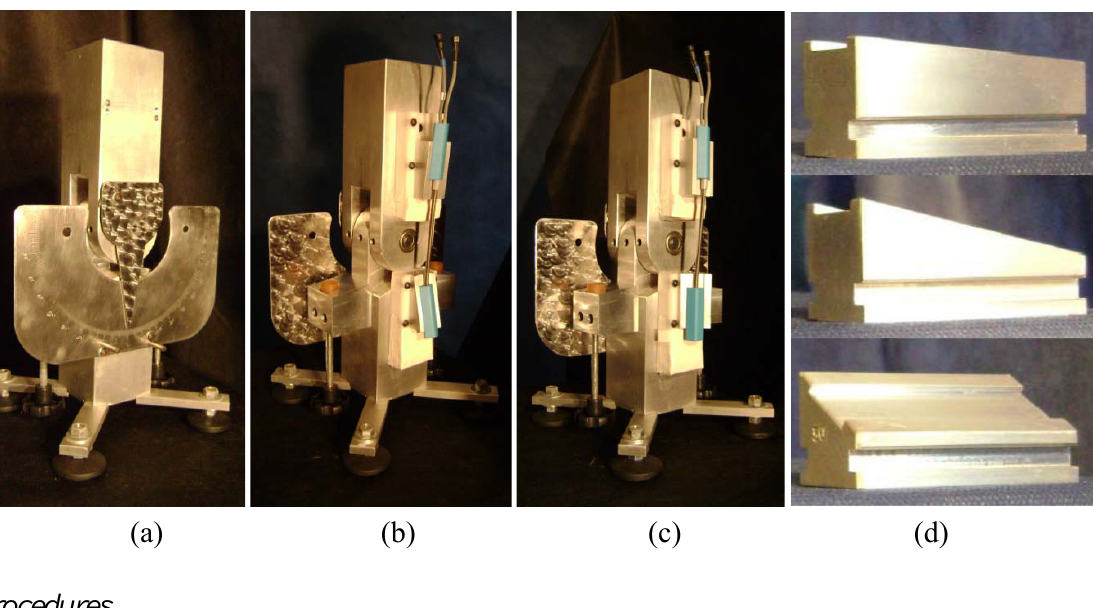
Figure 4. Jig, wedges and electrogoniometer used in the tests. (a) The graded angular scale is seen at the back of the jig; (b) 20° valgus misalignment wedges (in bright color) applied to the goniometer endblocks mounted in the jig: upper wedge 6° and lower wedge 14°; (c) 30° external rotational misalignment applied to the goniometer endblocks mounted in the jig: upper wedge 0° and lower wedge 30°; (d) 6° valgus/varus wedge (top), 14° valgus/varus wedge (middle) and 30° rotation wedge